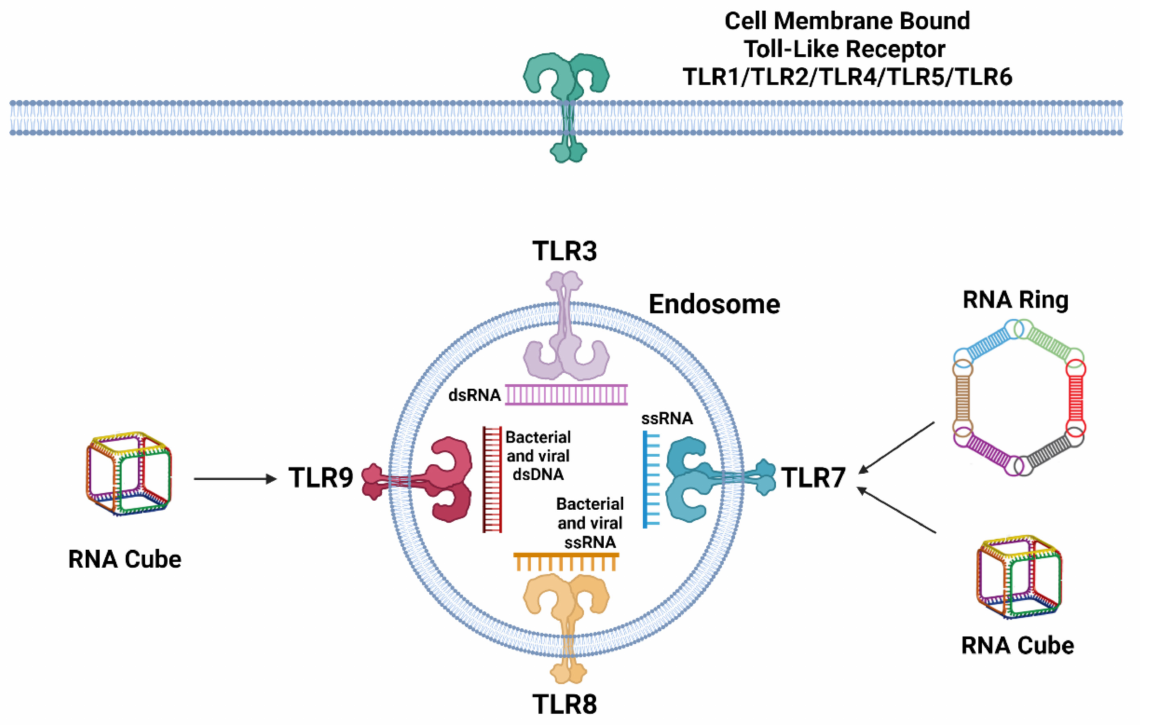
Figure 1. Toll-like receptors. Cell membrane-bound TLRs include TLR1, TLR2, TLR4, TLR5, and TLR6, while endosomal TLRs include TLR3, TLR7, TLR8, and TLR9. TLR3 recognizes double-stranded RNA (dsRNA). TLR8 recognizes bacterial and viral single-stranded RNA (ssRNA). TLR7 recognizes single-stranded RNA (ssRNA), as well as ring and cube RNA. TLR9 recognizes bacterial and viral double-stranded DNA (dsDNA), along with cube RNA. It is important to note that RNA cube triggers the activation of TLR9 and TLR7 only after its delivery inside the cell using a carrier such as